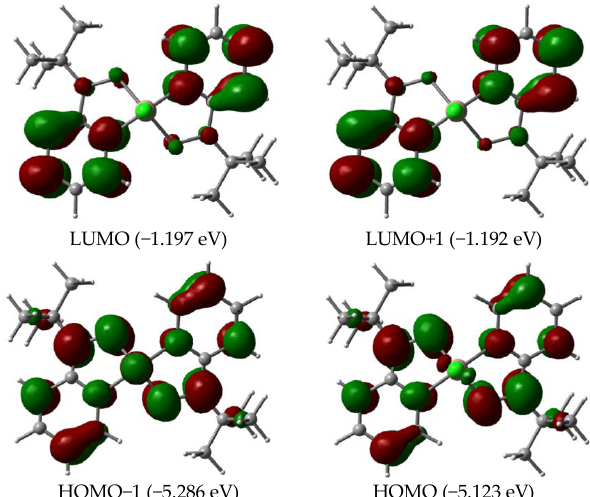
Figure 3. The frontier molecular orbitals of the (pyNO − ) 2 GaCl complex. The orbitals are visualized looking down the Ga–Cl bond.